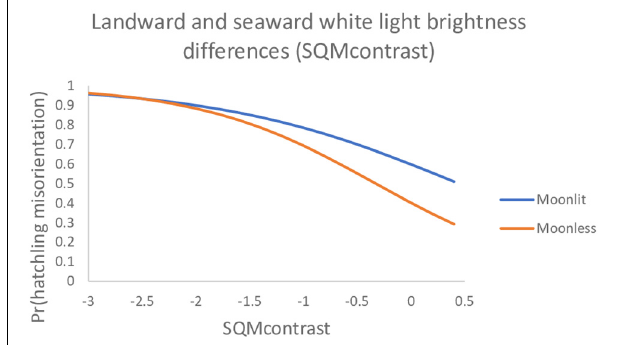
FIGURE 3 | The probability loggerhead ( Caretta caretta ) hatchlings were misoriented on moonlit vs. moonless nights under a model with SQMcontrast only (80 ◦ AOA, 10 ◦ SQM data). Data are plotted only over the range of SQMcontrast values actually observed in both subsets of the data. The full range observed for both data sets combined was − 5 to